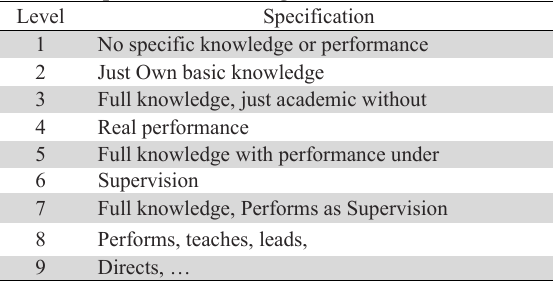
An example for "Risk Management"